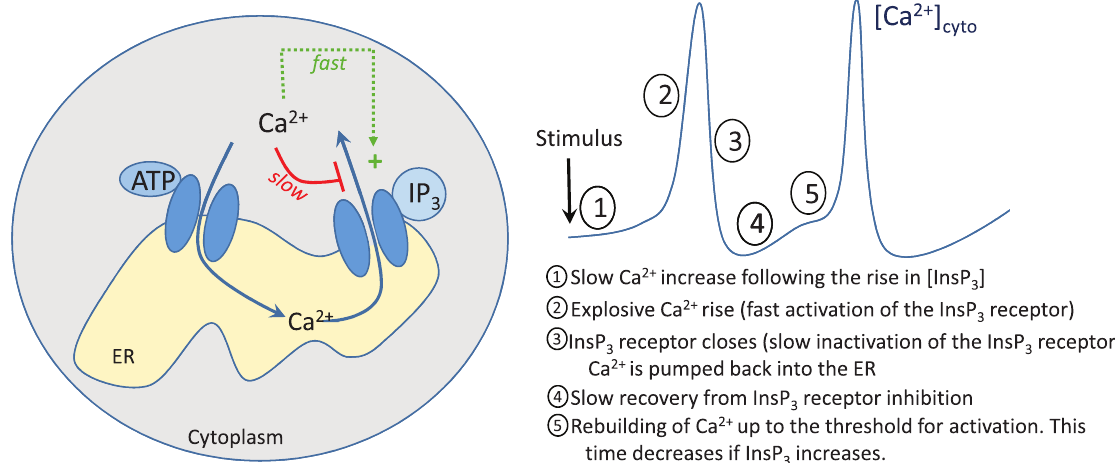
Figure 1. Basic mechanism of cytosolic Ca 2+ oscillations in non-excitable cells. These oscillations are initiated by the stimulus-induced rise in inositol 1,4,5-trisphosphate (InsP ) concentration and occur through a repetitive exchange of Ca 2+ between the cytoplasm and the 3 endoplasmic reticulum (ER).